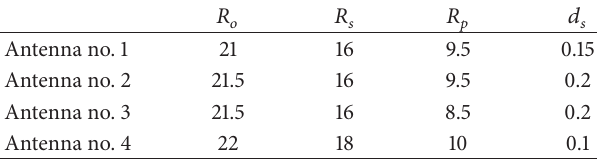
Table 1: Dimensions of the designed antennas. All dimensions are in